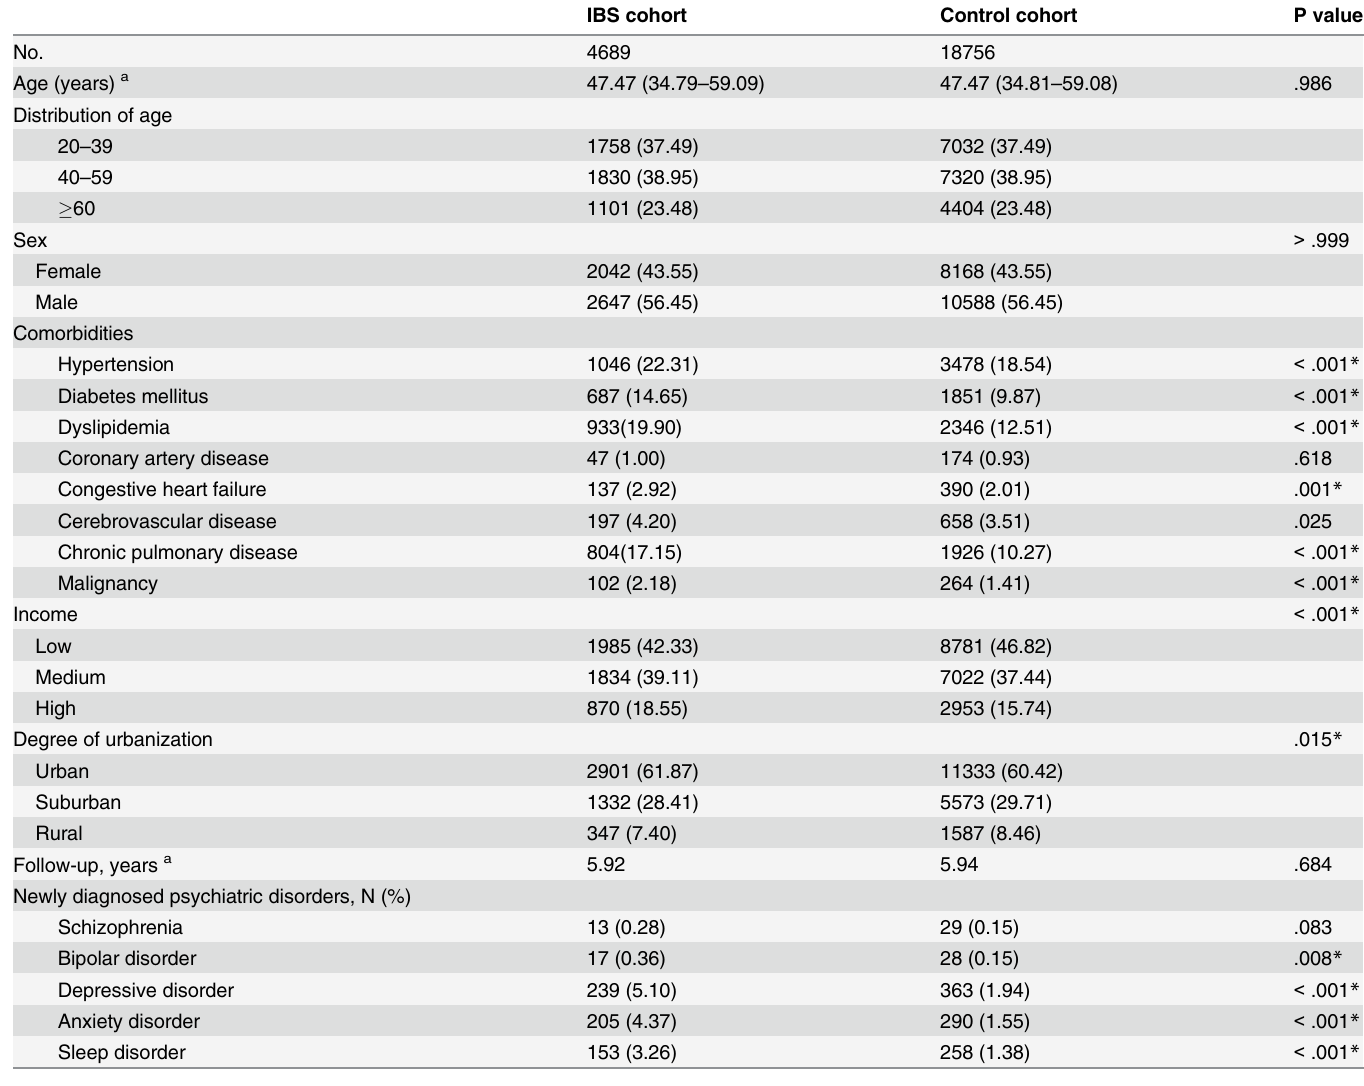
Table 1. Characteristics of IBS and control